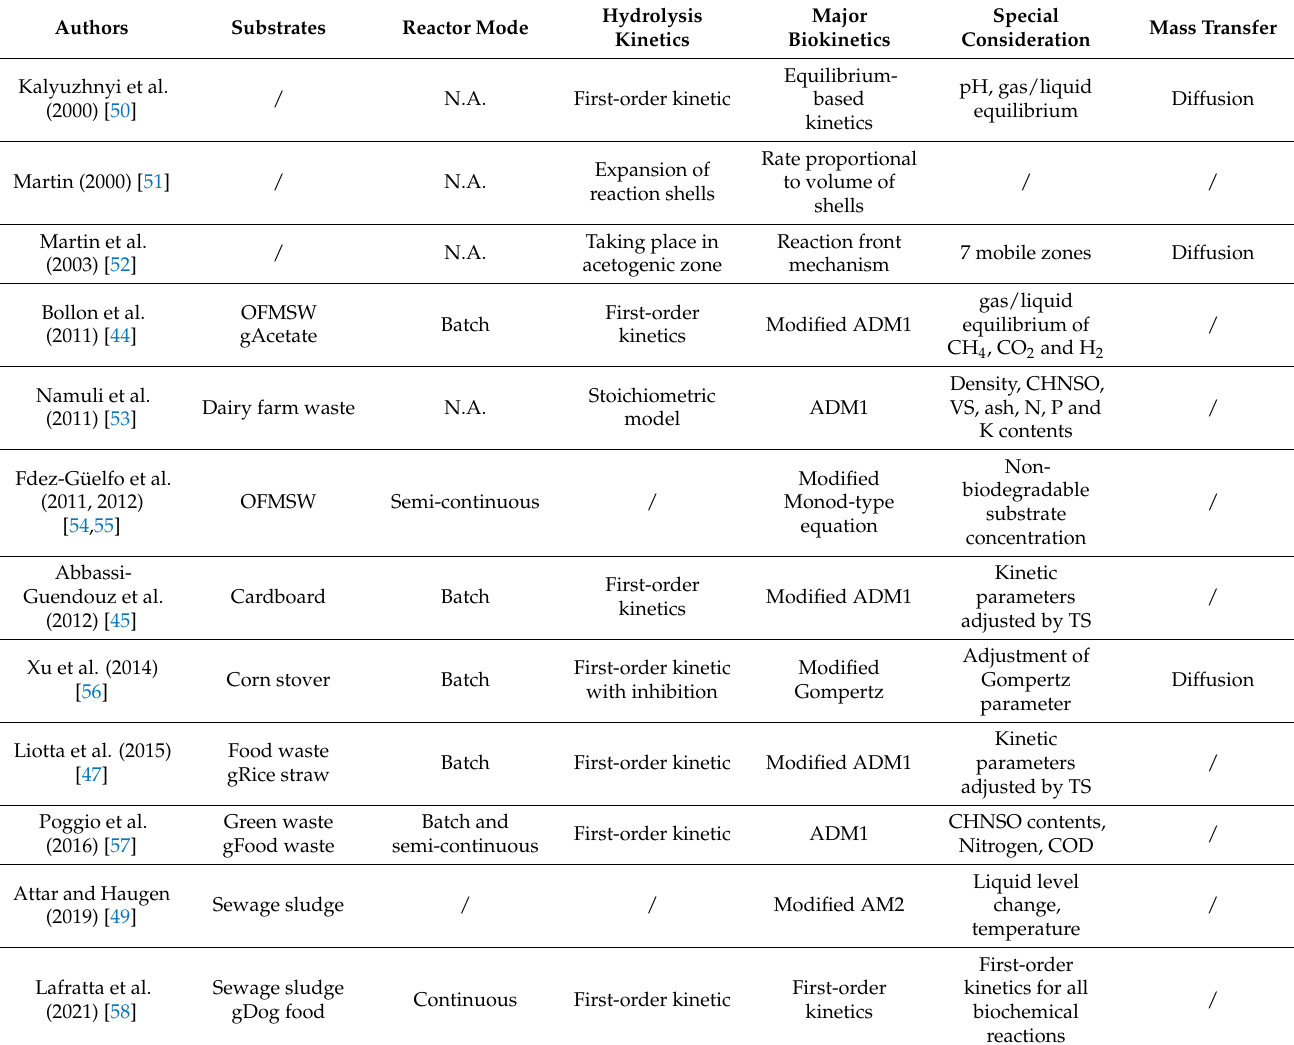
Table 1. Summary of simulation studies on SSAD processes supposing a perfect mixed